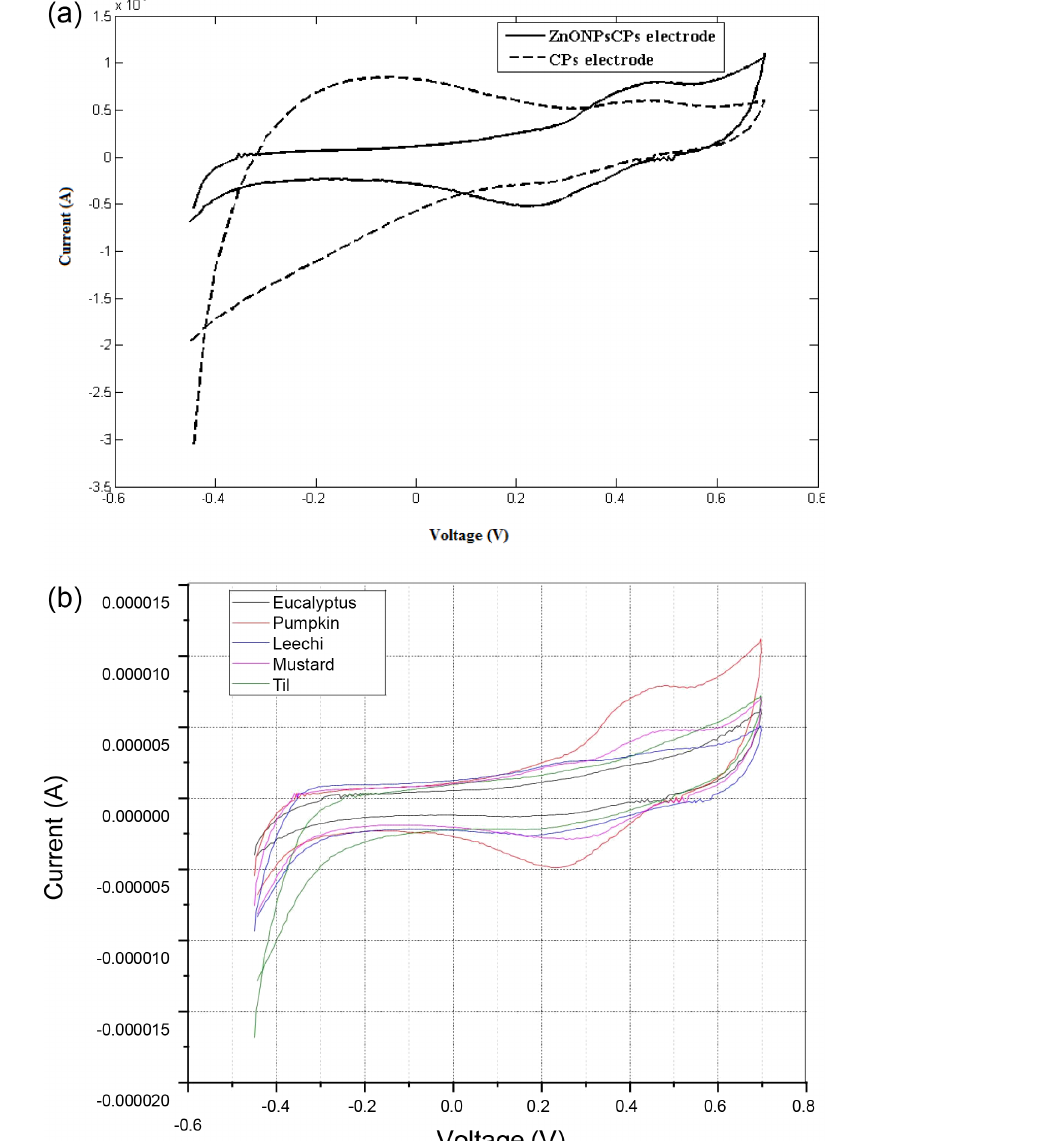
Figure 5. (a) Cyclic voltammograms of the Cps electrode and ZnONPs modified Cps electrode in the Eucalyptus floral type of honey at 0.3Vs − 1 in a potential window from the − 0.45 to 0.7 vs. Ag / AgCl reference electrode. (b) Cyclic voltammograms of the ZnONPs modified CPs electrode for five different floral types of